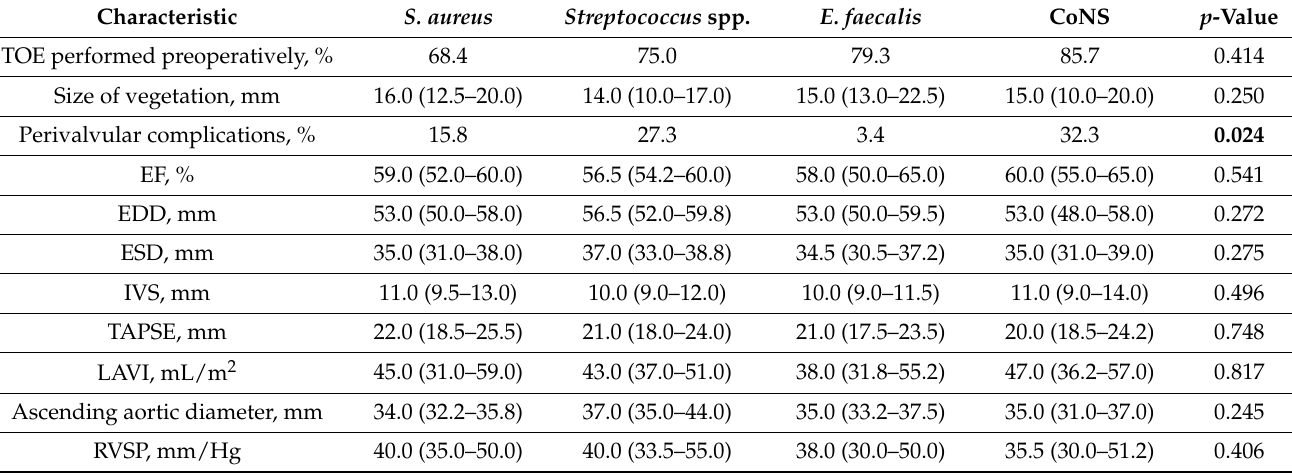
Table 5. Echocardiographic findings and parameters observed in IE caused by various microorganisms.